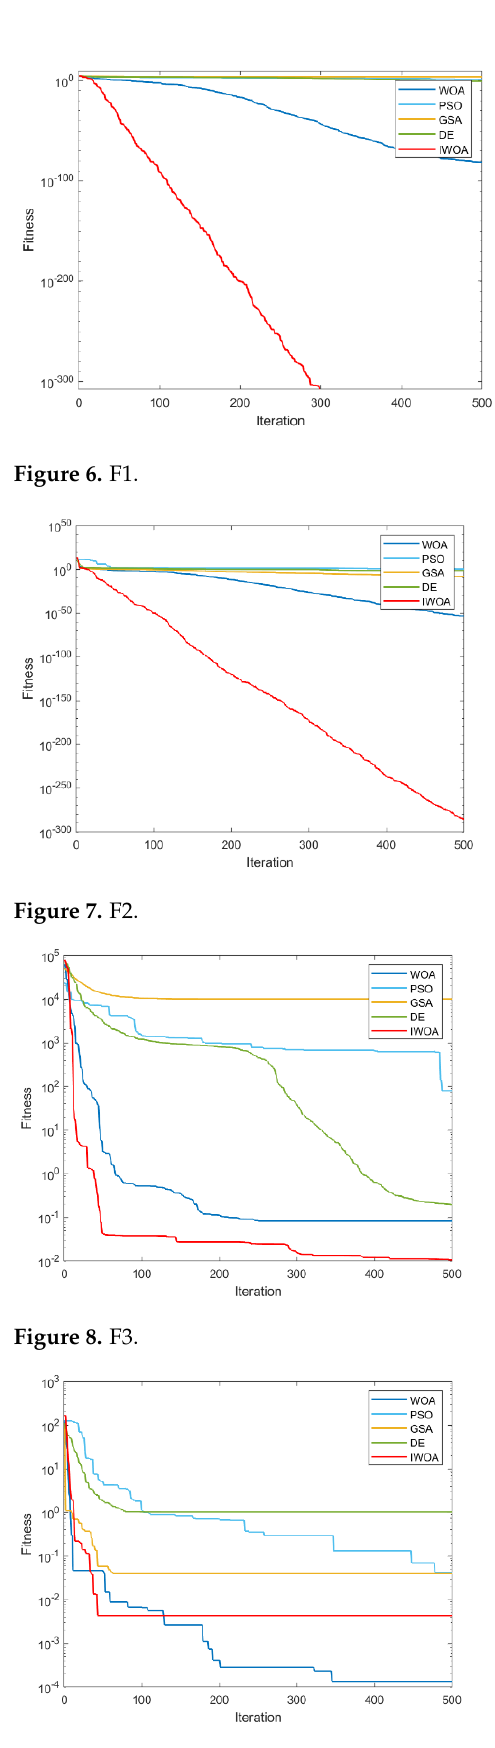
Figure 9. F4. Figure 9. Figure 9. F4.